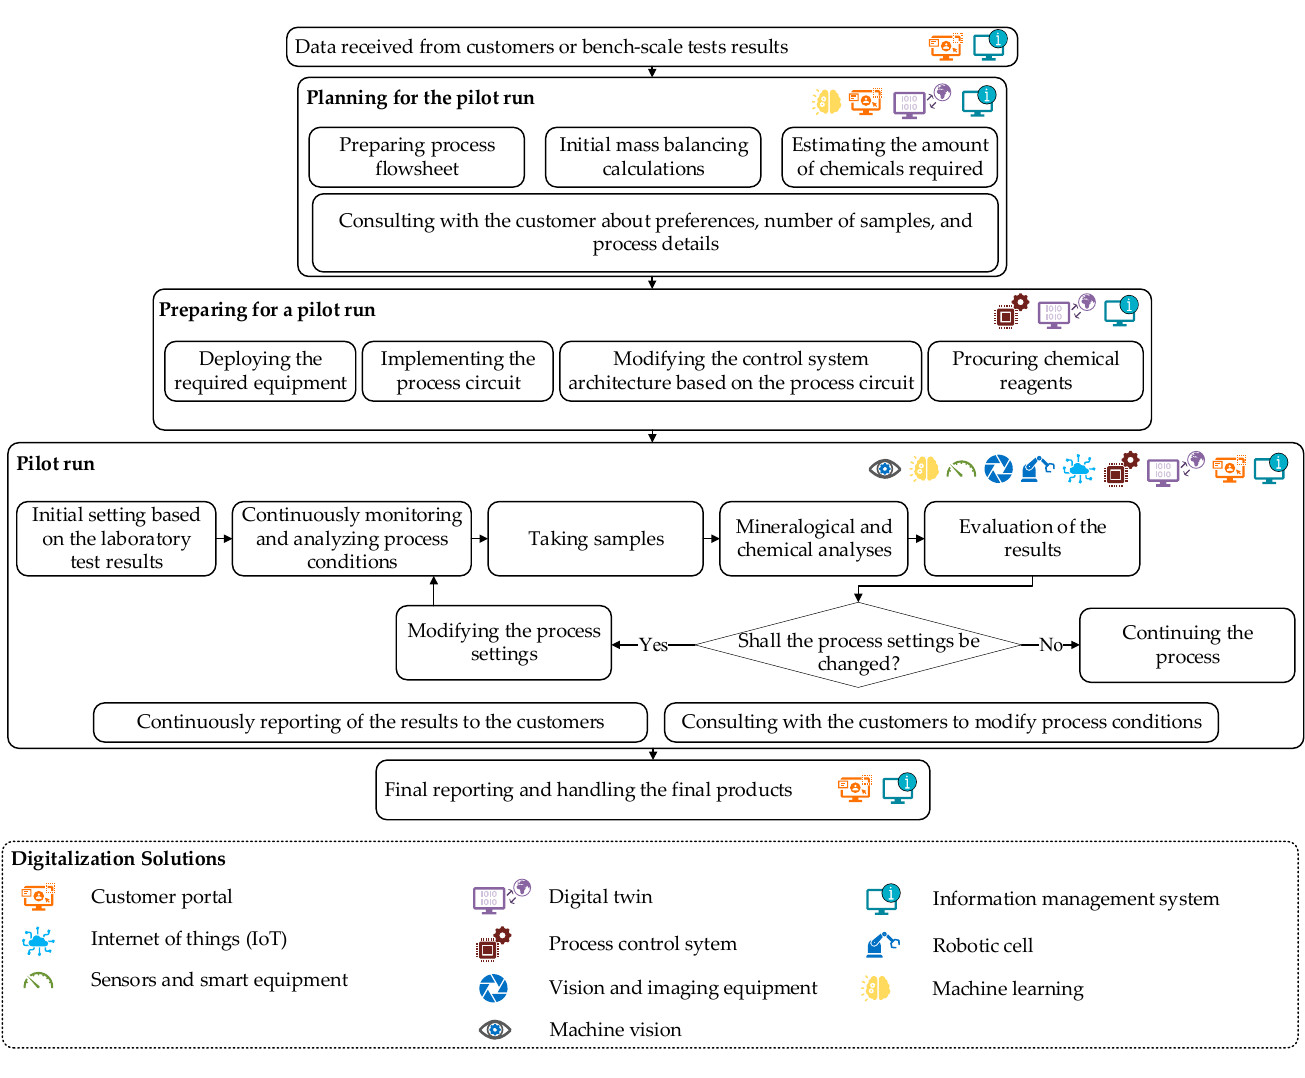
Figure 5. Flowchart of the different steps of a mineral processing pilot project and the corresponding digitalization solutions.